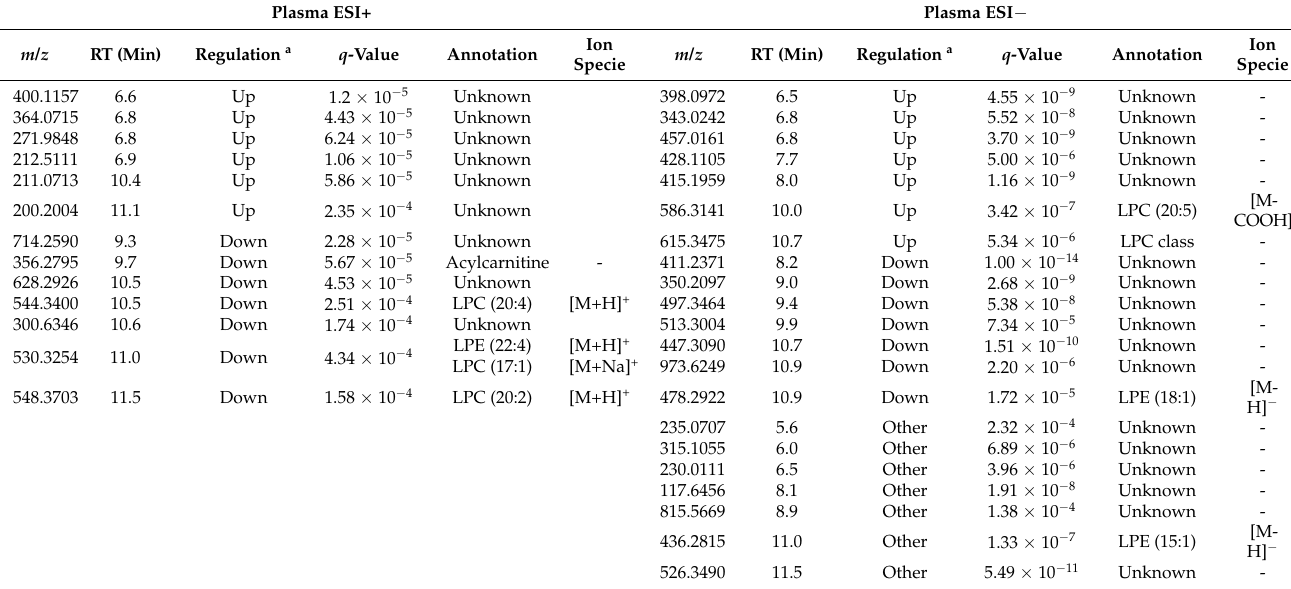
Table 3. Significant features in plasma samples at positive and negative ionization modes that are considered real peaks after applying univariate analysis in the independent data sets. The table includes the m / z values, the retention time (RT), tendency, q -value ( p -value after applying false discovery rate), the putative annotation, and the ion